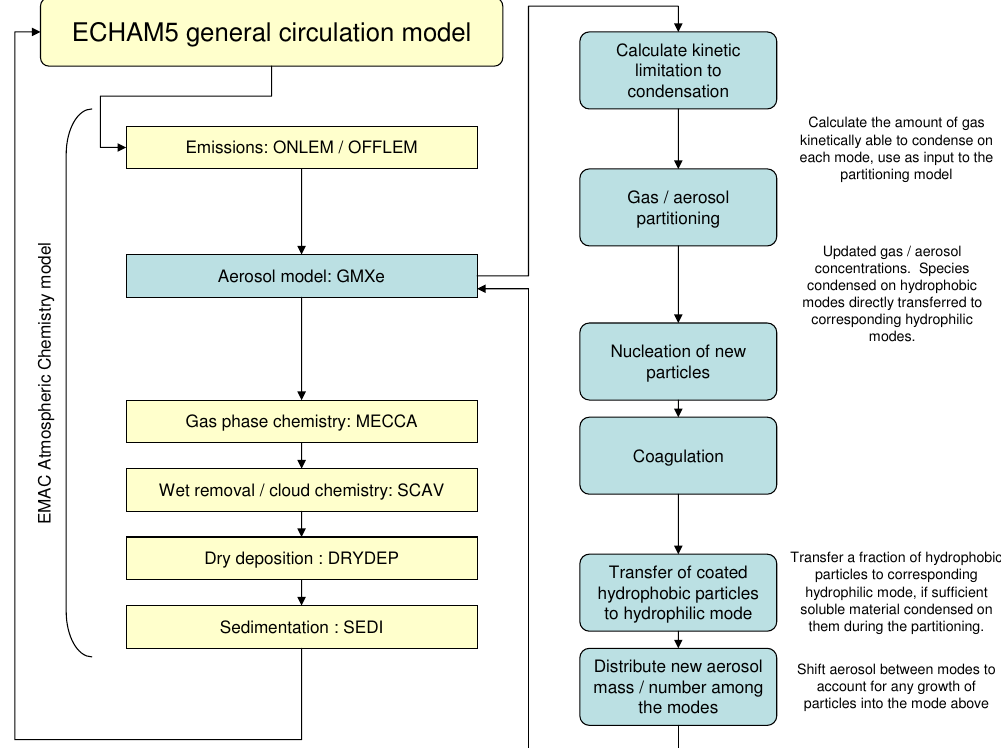
Fig. 1. Graphic summarising the calling sequence of the processes in the GMXe model, implemented within the ECHAM/MESSy Atmo- spheric Chemistry